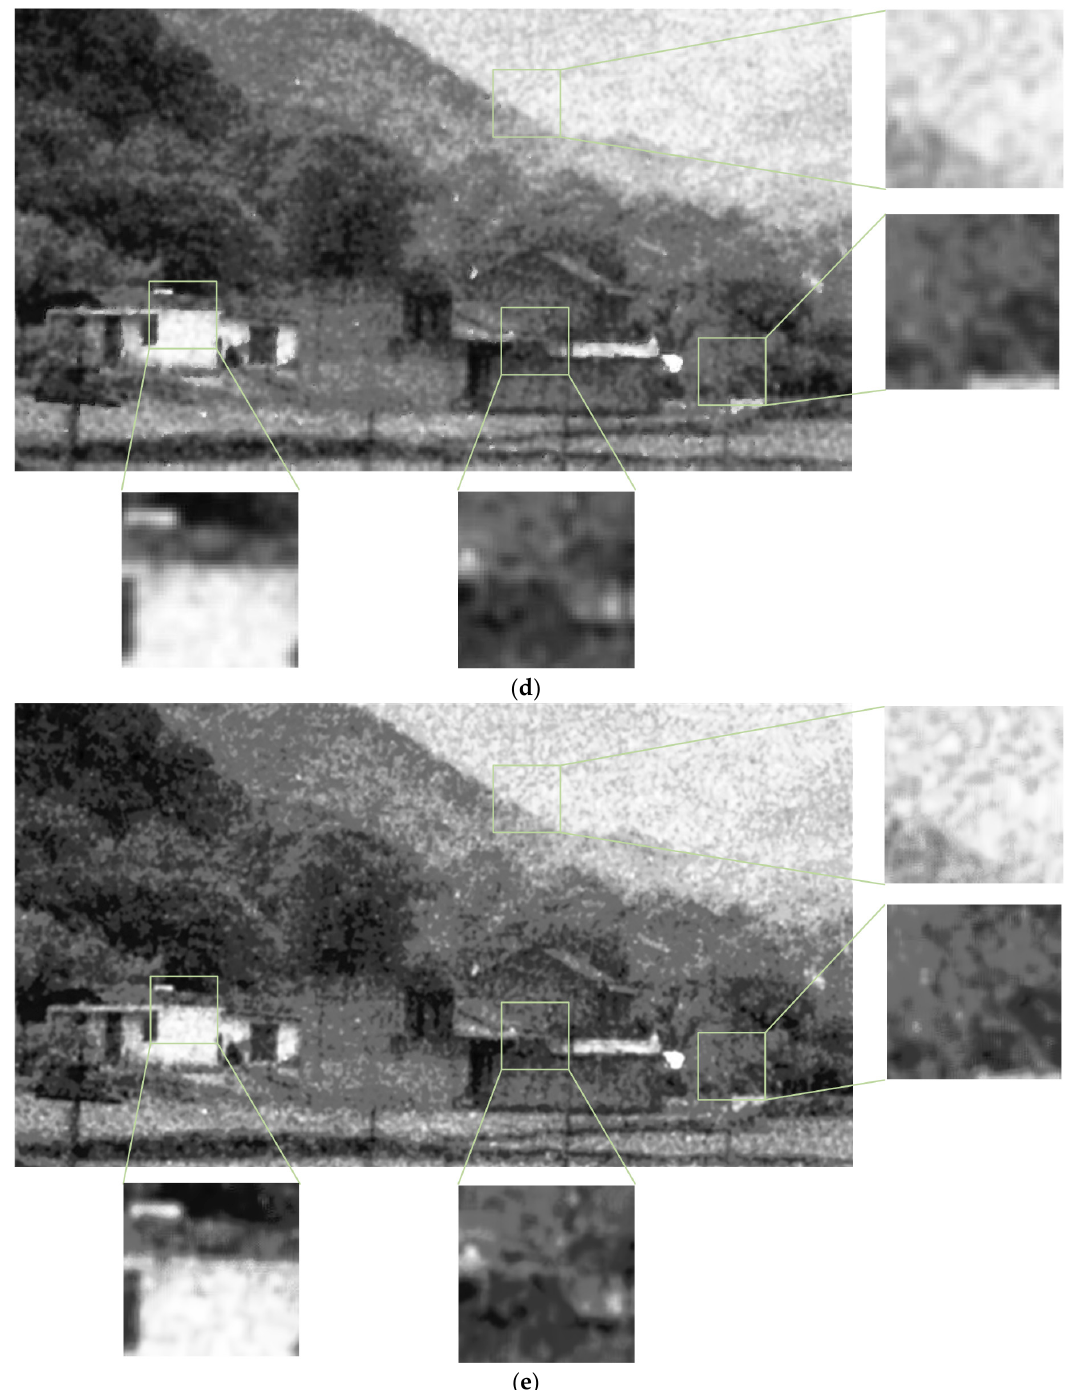
Figure 7. The subjective results of the proposed scheme and others. ( a ) a real ICCD sensing image; ( b ) the result of the proposed scheme; ( c ) the result of BM3D; ( d ) the result of the denoising method based on the K-SVD; ( e ) the result of BLS-GSM.